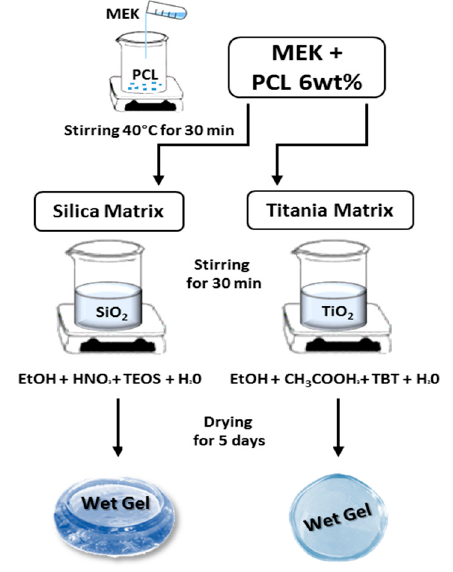
/ SiO / TiO 2 and PCL 2 gel